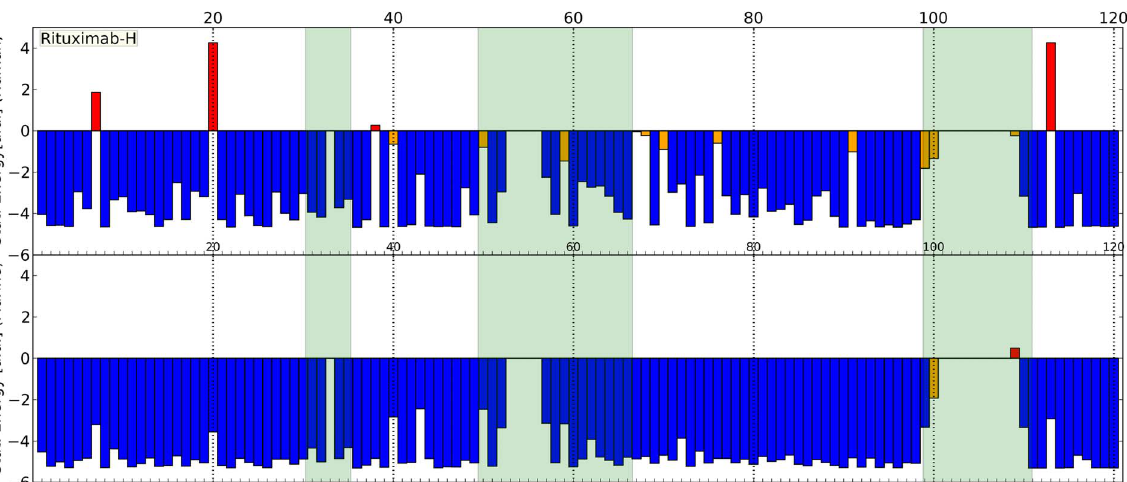
Figure 2. Sequence analysis of Rituximab-VH. Contributions to the total score are mapped onto individual residues. Yellow and red colors indicate that this amino acid is uncommon in this position and/or shows unfavourable couplings with other positions. Green shaded areas indicate CDRs of which some residues are not taken into account. Upper graph: Ritxumab heavy chain with human heavy chain potential (F Hh ). Lower graph: Rituximab heavy chain with murine heavy chain potential (F Hm ).